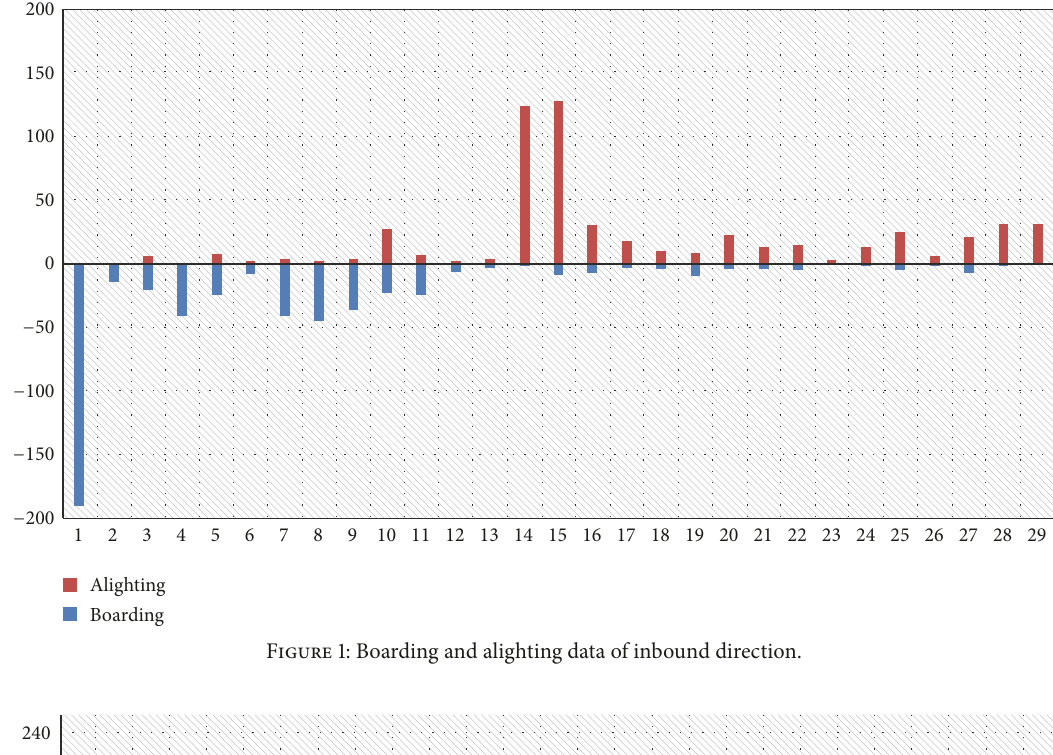
Figure 1: Boarding and alighting data of inbound direction.